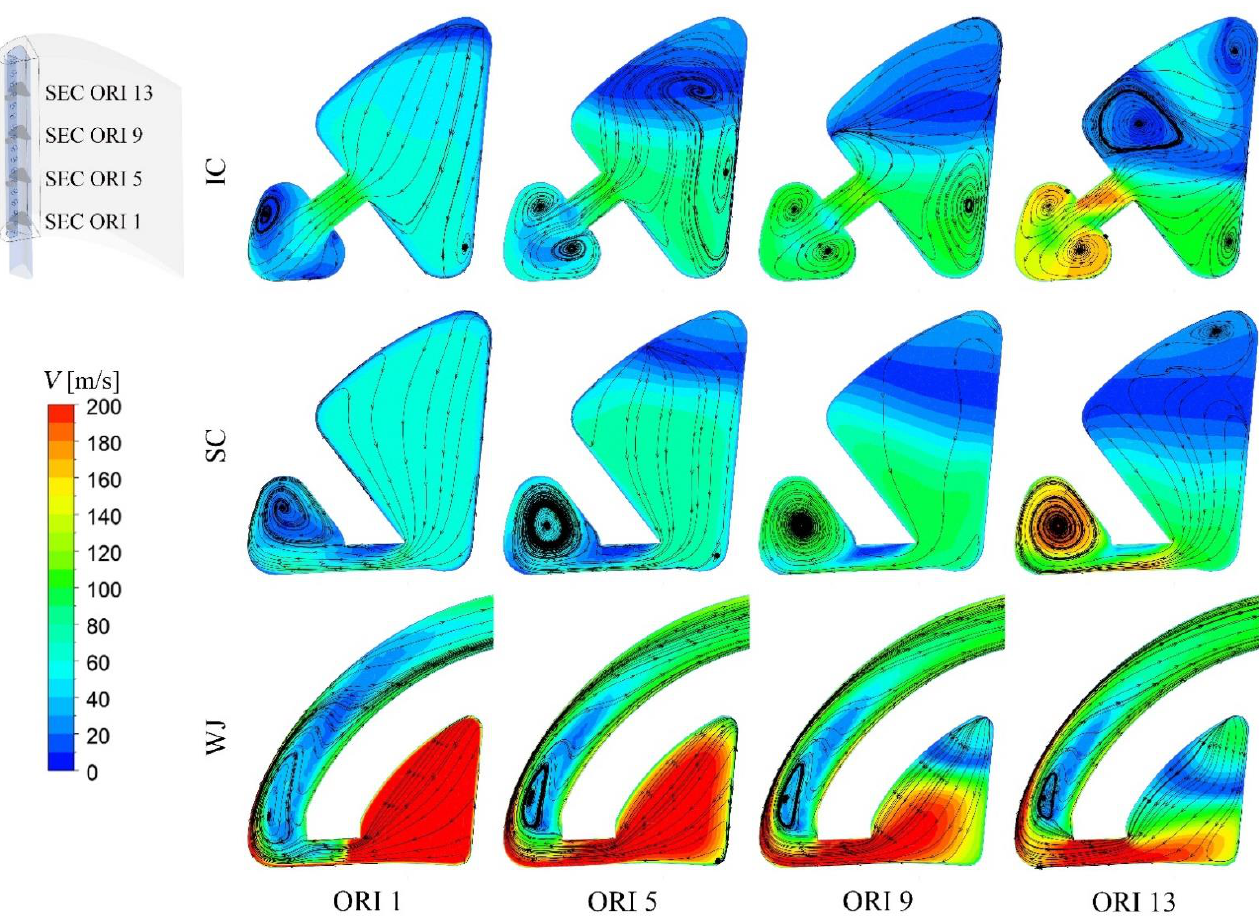
Figure 16. Streamline and velocity contours in mid-span section with different internal cooling structures ( Re j = 20,000).